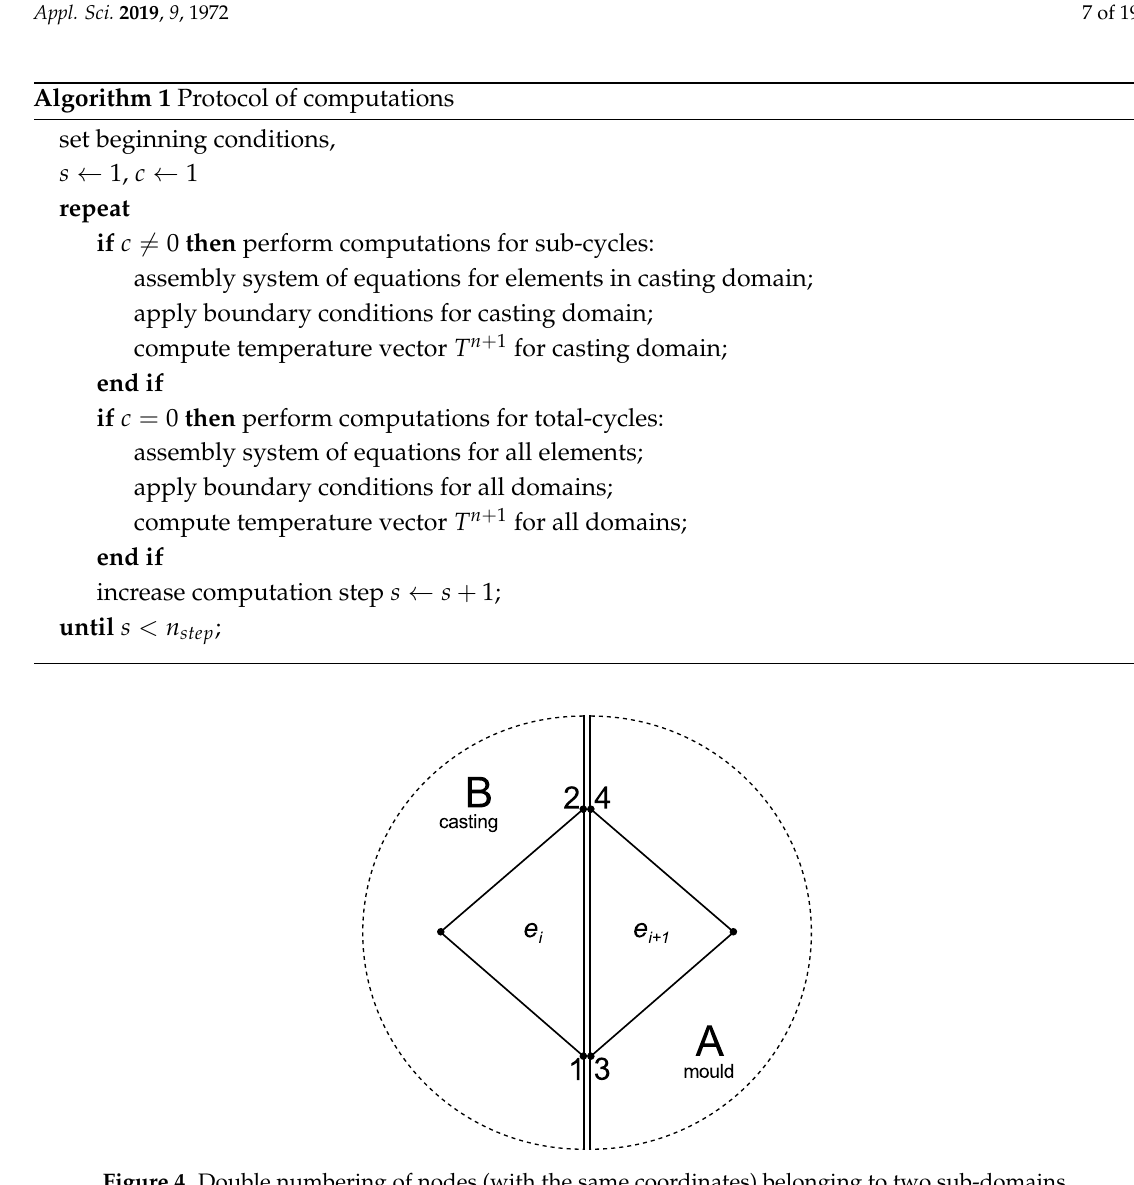
Figure 4. Double numbering of nodes (with the same coordinates) belonging to two